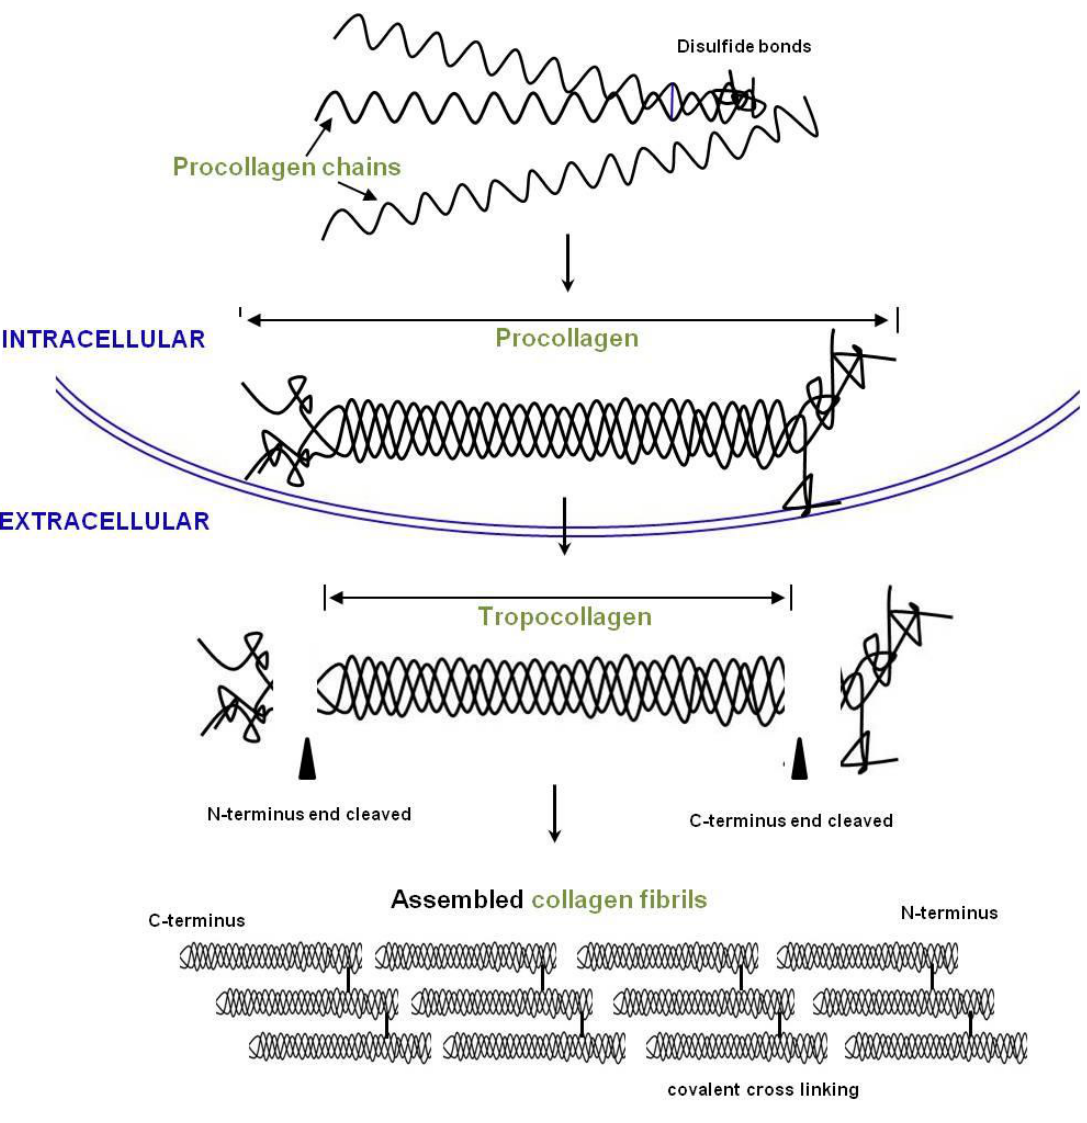
Figure 6. Overview of collagen production. Procollagen chains are synthesized and form a helix in the endoplasmic reticulum (ER). Propeptides are removed by proteinases, and the fibrils are assembled into collagen fibers in the extracellular space (EC).